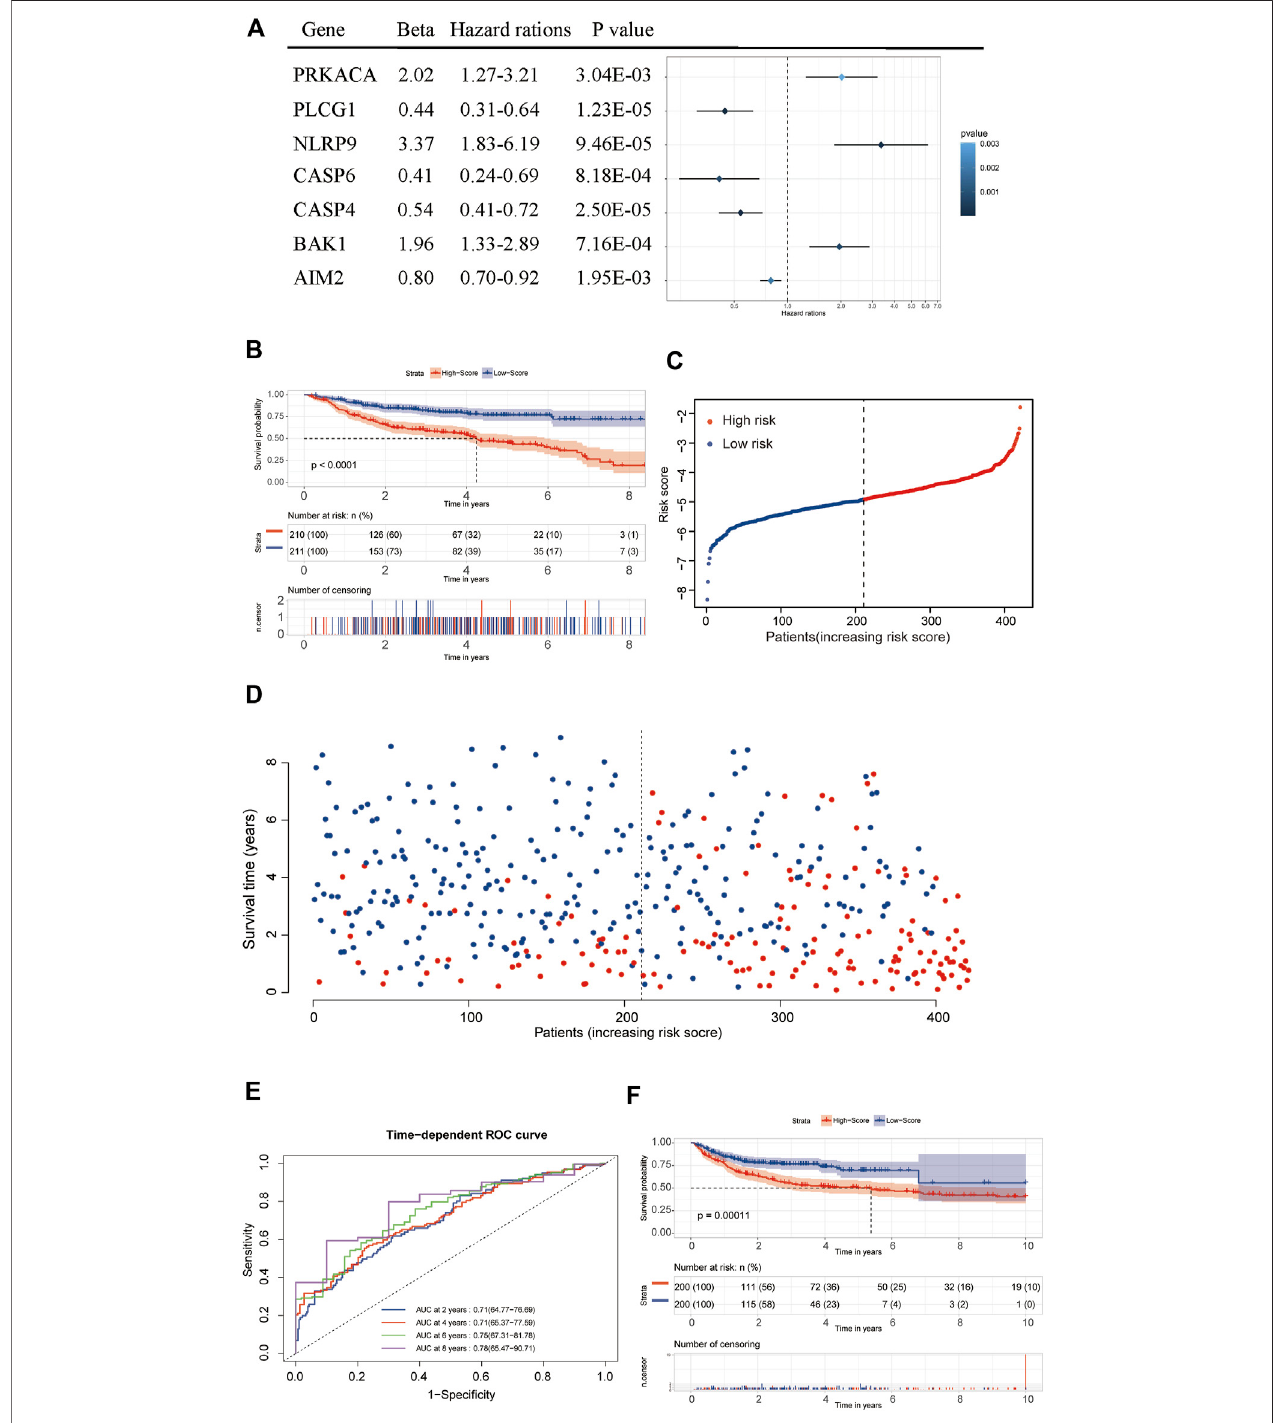
FIGURE 6 | Establishment and validation of the seven-gene prognostic signature. (A) Forrest plot of the multivariate Cox regression analysis of seven genes. (B) A Kaplan – Meier survival analysis in the training dataset. (C,D) The distribution of risk scores and living status of DLBCL patients in the training dataset. (E) An ROC curve analysis of the signature. (F) A Kaplan – Meier survival analysis in the validation dataset. the prognosis between the clusters ( Figure 8A ). The low-risk the pyroptosis risk group and IPI score, response to treatment group had a higher pyroptosis signature score than the high-risk and PRG-related clusters and visualized them using an alluvial group ( Figure 8B ). We further analyzed the relationship between diagram ( Figure 8C ). It was evident that the low-risk group had